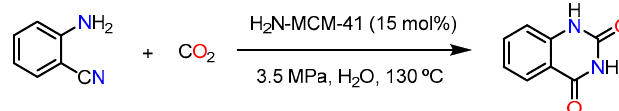
Figure 4. Synthesis of quinazoline-2,4(1 H ,3 H )-dione derivatives.